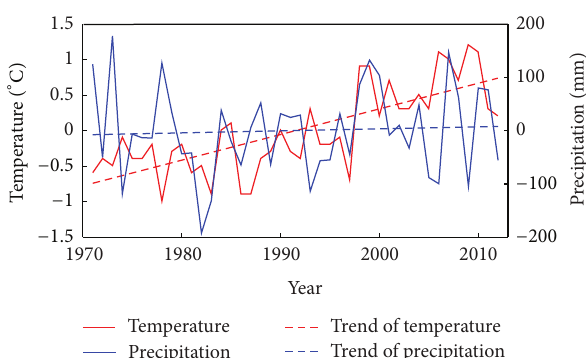
Figure 6: Anomalies in air temperature and precipitation from 1971 to 2012 at the Dingri meteorological